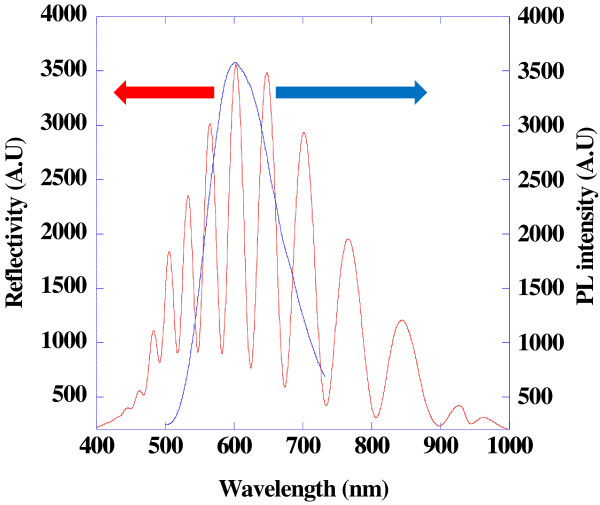
Reflectivity (red line) and photoluminescence (blue line) spectra of photoluminescent PSi.